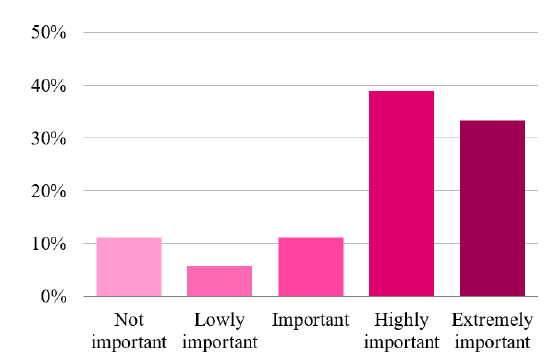
Fig. 4. Question: “How interest would you be in trying a solution if you had to pay only for the services received, without any initial investment?”.